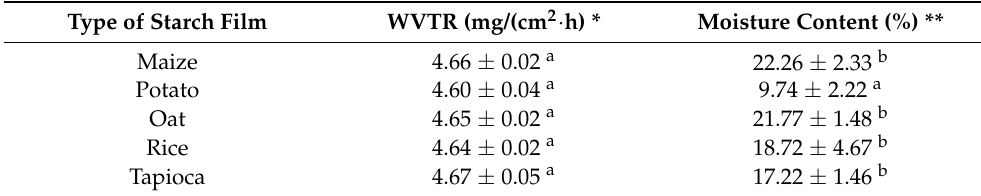
Table 5. Water vapour transmission rate (WVTR) and moisture content of various starch